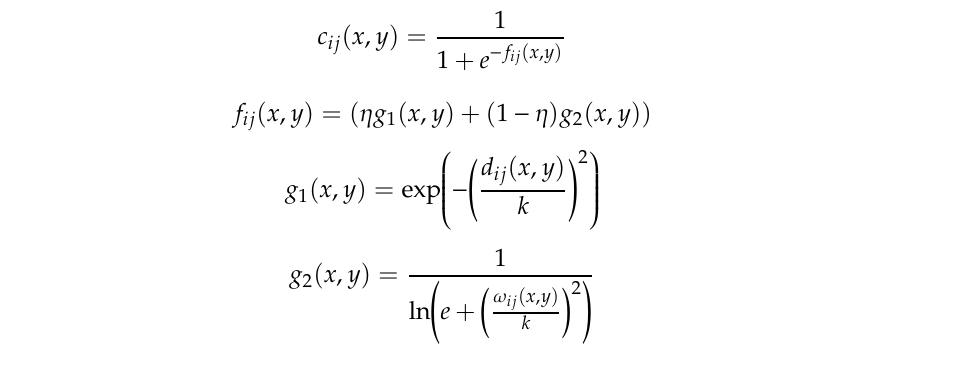
Figure 5. Changes of environmental similarity according to parameter h.